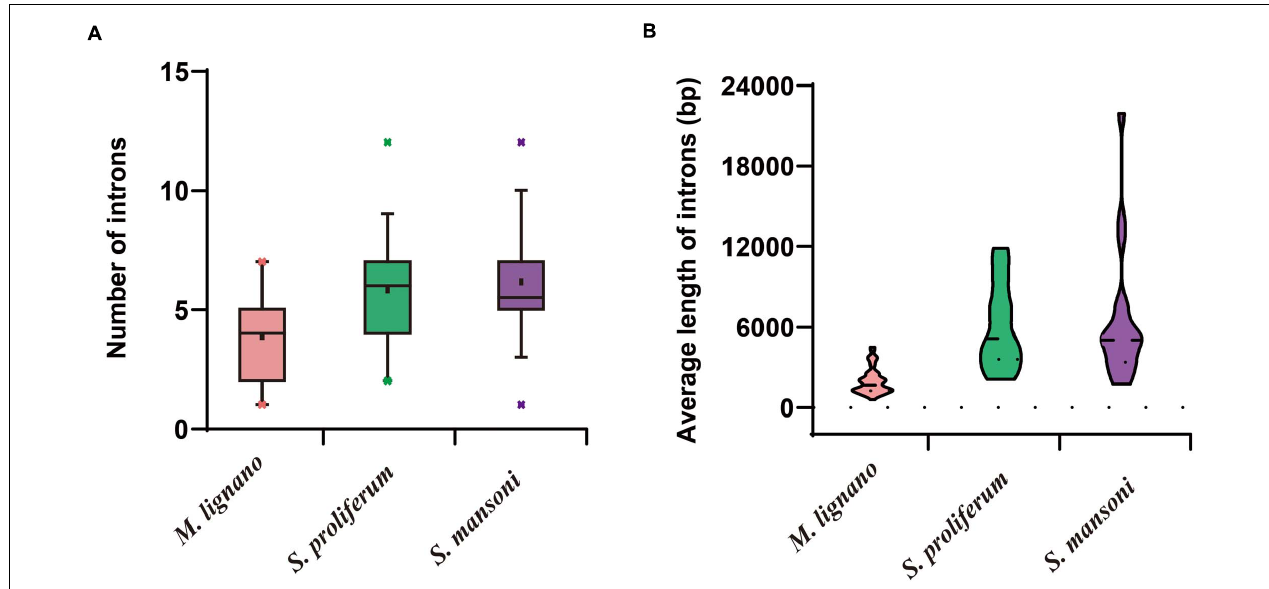
FIGURE 6 | Differences of introns in M. lignano , S. proliferum , and S. mansoni . (A) Distribution of intron numbers in flatworm species. (B) Distribution of intron length in flatworm